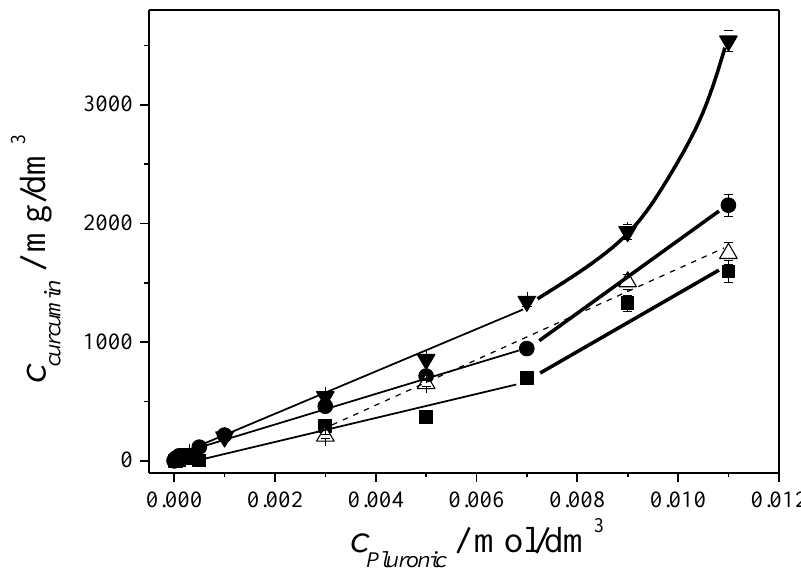
Figure 2. Curcumin concentration as a function of molar concentration of Pluronic 108 ( (cid:4) ),94 ( (cid:52) ), 127 ( • ) and 105( (cid:72) ) in aqueous solution. (Lines are just to guide eyes).